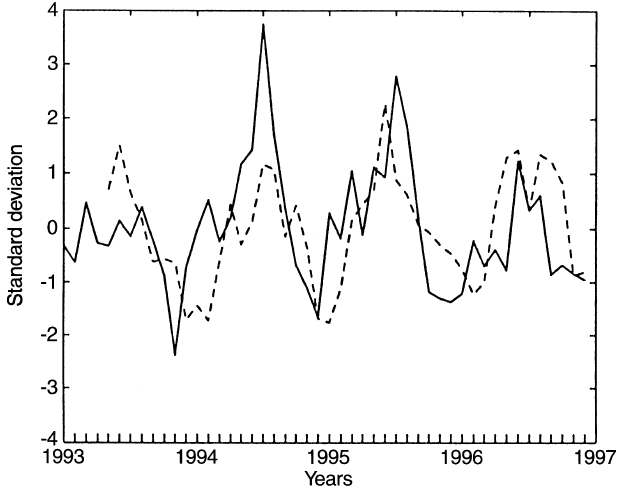
Fig. 5. Monthly means of the PG (in V/m) based on data between 05 UT and 08 UT ( solid line ), filtered annual component ( dashed line ) and filtered semiannual component ( dotted line ) for the same interval as in